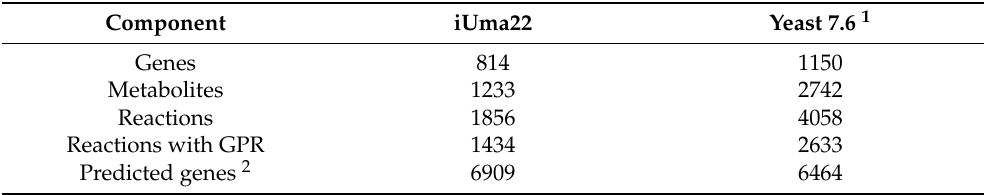
Table 2. Number of metabolites, reactions, and genes of the genome-scale metabolic model of U. maydis iUma22 and, in comparison, the community yeast model (8.5.0 [42]).